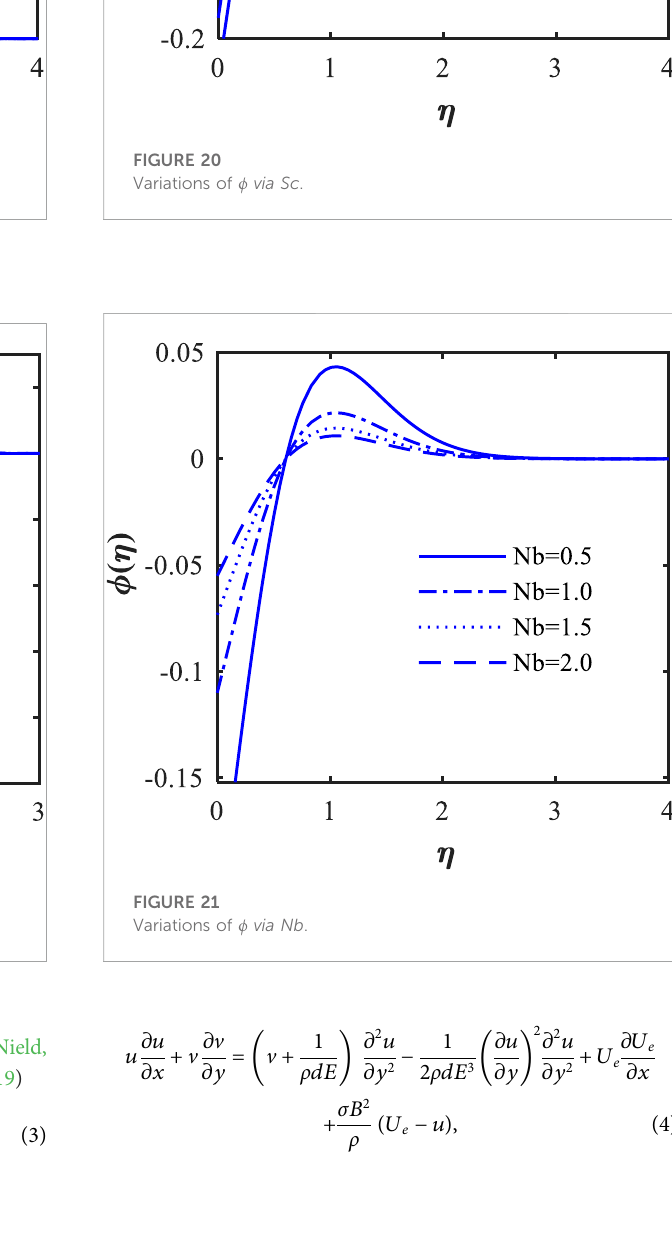
FIGURE 18 Variations of θ via Nt .